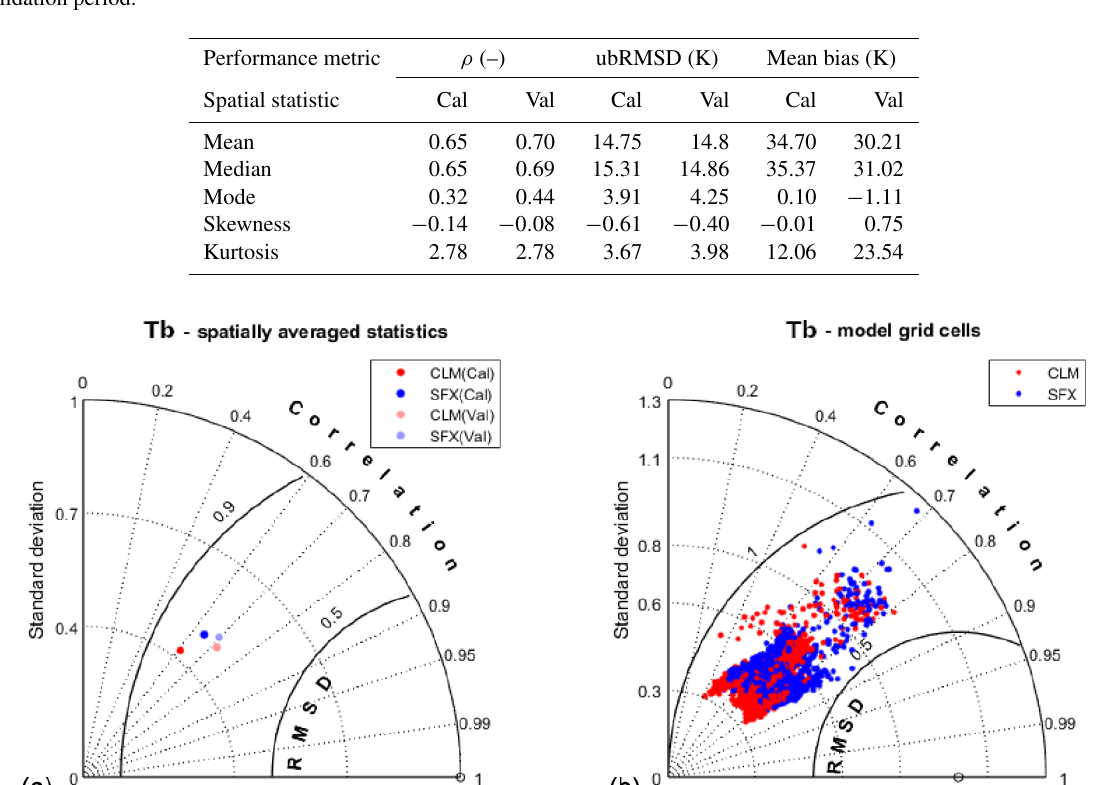
Figure 4. Taylor diagrams (TDs) based on the comparison between SMOS-observed and SFX- and CLM-simulated Tb, respectively. The TD in panel (a) is drawn by spatially averaging model grid cell statistics, separating the calibration (Cal) and validation (Val) periods, and the TD in panel (b) is drawn using model grid cell statistics individually for calibration and validation periods together. Red dots indicate CLM statistics, and blue dots indicate SFX